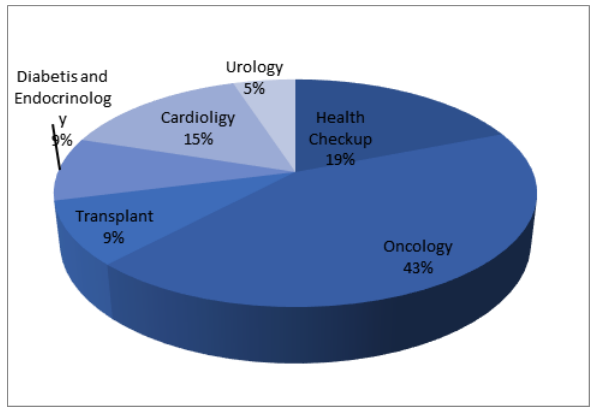
Figure 3 . Treatment opted by international patients